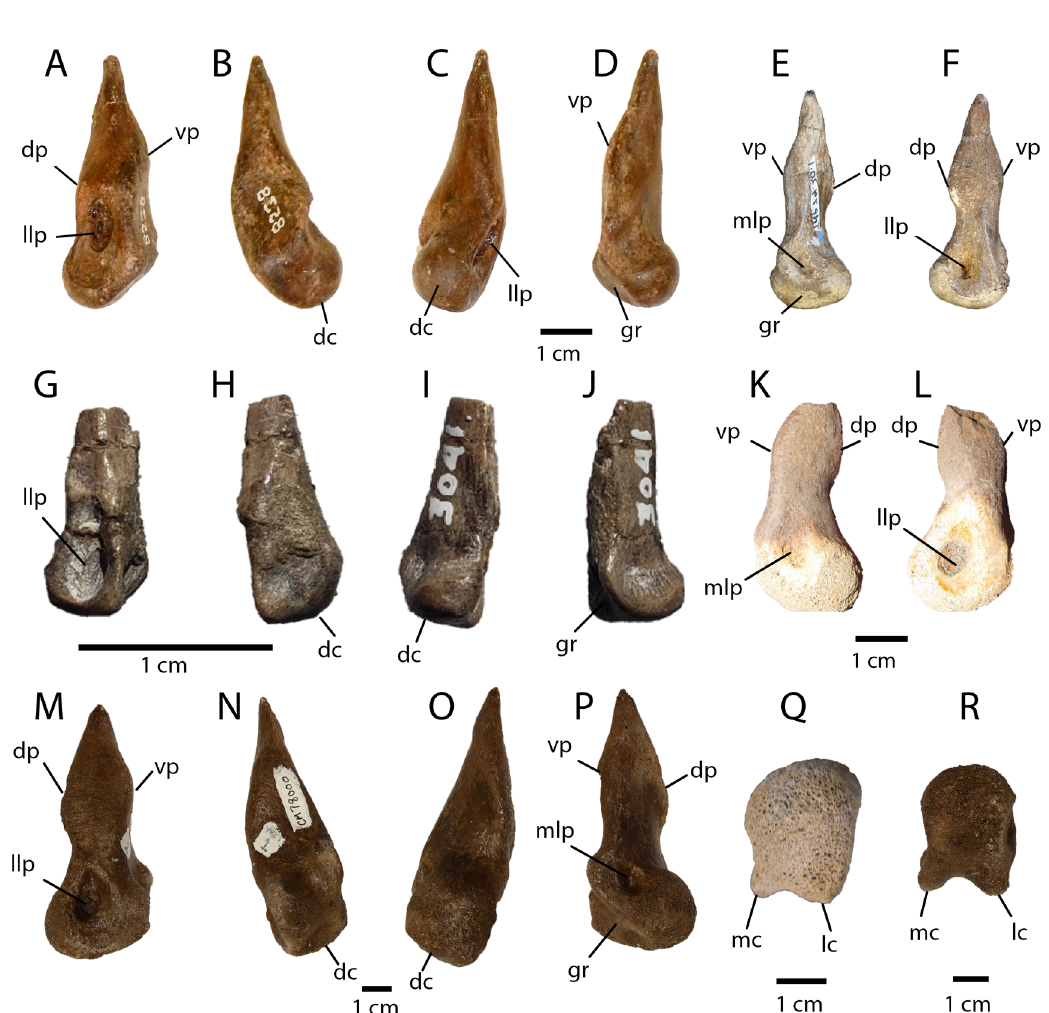
Figure 3. Comparison of metatarsal I morphology among caenagnathid theropods from North America. A−D, CMN 8538 “ Macrophalangia canadensis ” (mirrored) in A, lateral; B, ventral; C , dorsal; and D, medial views. E−F, TMP 1979.020.0001 Chirostenotes pergracilis (mirrored, from Funston, 2020), in E, medial and F, lateral views. G−J, AMNH 3041 Microvenator celer in G, lateral; H, ventral; I, dorsal; and J, medial views. K, L, Q, BDM uncatalogued specimen Anzu wyliei in K, medial; L, lateral and Q, distal views. M−P, R, CM 78000 Anzu wyliei in M, lateral; N, ventral; O, dorsal; P, medial and R, distal views. Abbreviations: dc, distal condyle; dp, dorsal prominence; gr, groove; lc, lateral hemicondyle; llp, lateral ligament pit; mc, medial hemicondyle; mlp, medial ligament pit; vp, ventral prominence. G-J are courtesy of the Division of Paleontology, American Museum of Natural History. K, L and Q, courtesy of Badlands Dinosaur Museum. M-P and R, courtesy of Section of Vertebrate Paleontology, Carnegie Museum of Natural